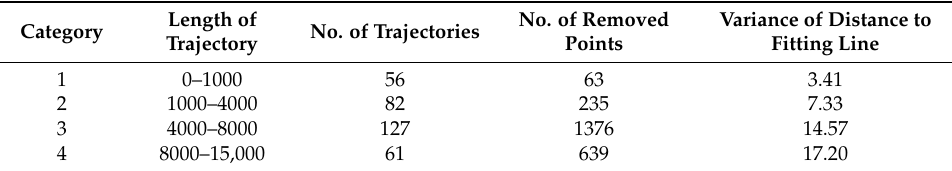
Table 3. Results of deleted noisy points in the trajectories.